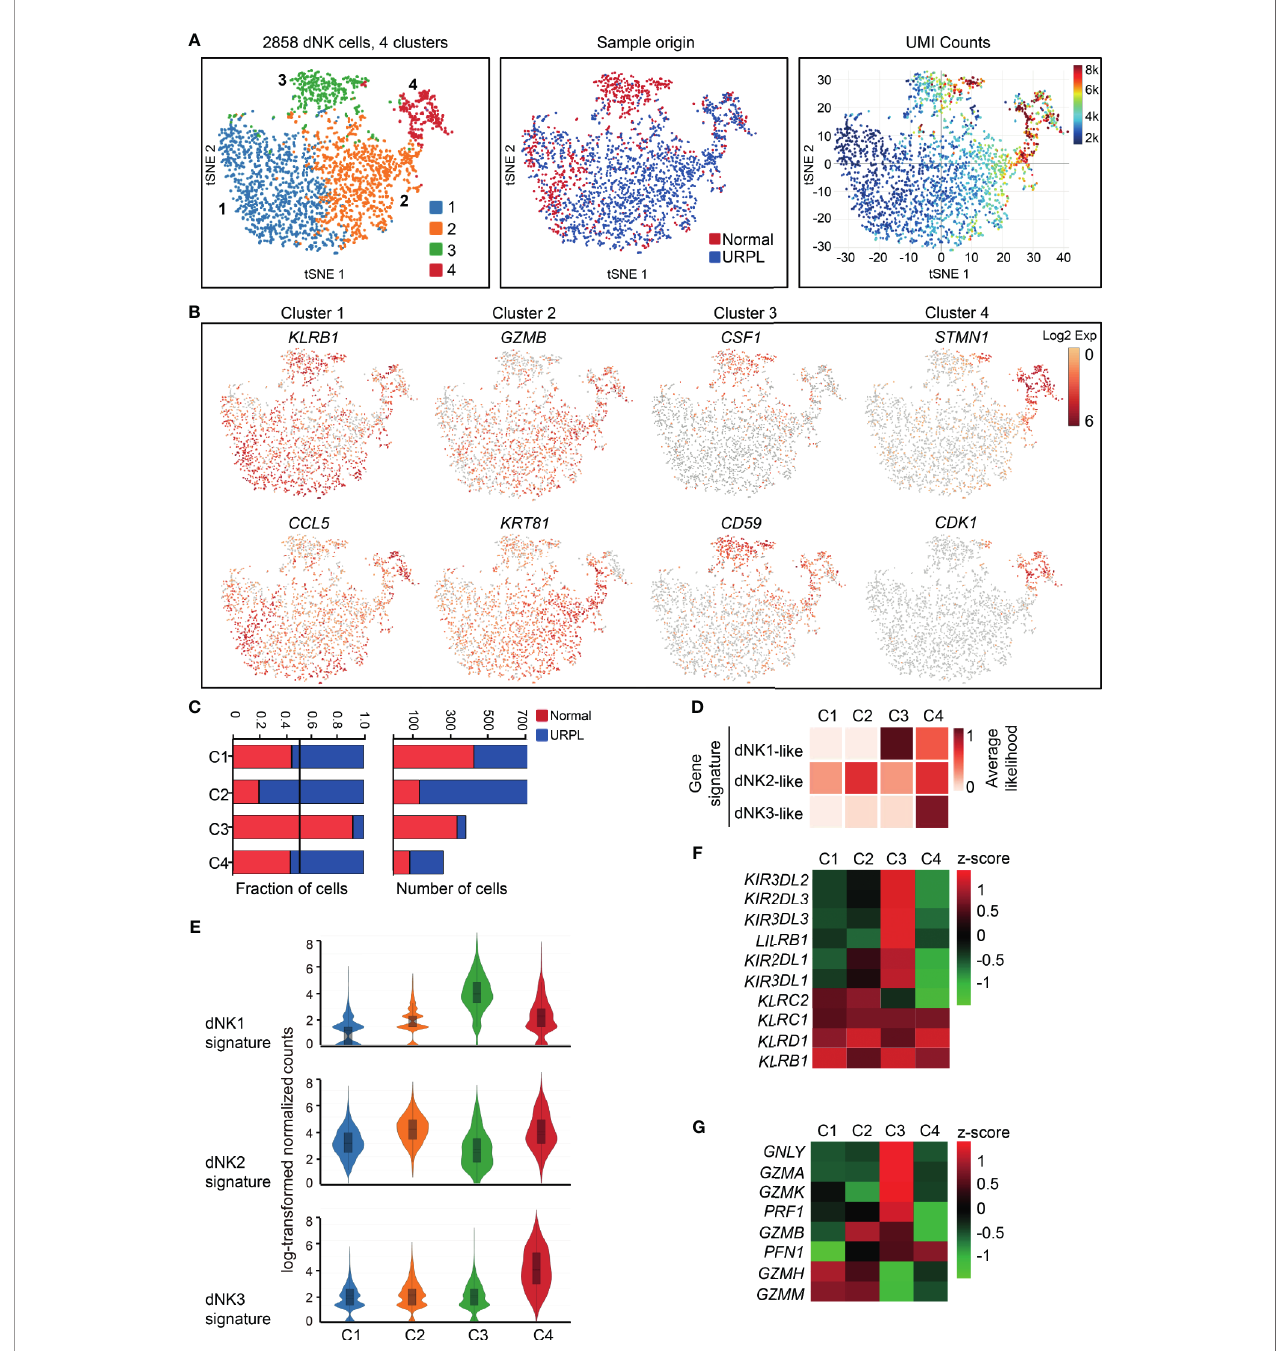
FIGURE 2 | Single-cell data revealed molecular details and subclusters of dNK cells. (A) tSNE of the dNK cells from Figure 1A (cluster 3,5,6), with each cell colorcoded for (left to right): the associated cell type, its sample type of origin (normal or URPL) and the number of transcripts (UMIs) detected in each cell (log scale as de fi ned in the inset). K, thousand. (B) Expression of marker genes for each subcluster above. (C) The fraction (left panel) and number (right panel) of cells originating from URPL and normal control samples for the 4 de fi ned subclusters. (D) Classi fi cation by dNK1, dNK2 and dNK3 gene signatures revealed the identity of the 4 subclusters above. (E) Violin plots showing the smoothened expression distribution of dNK1, dNK2 and dNK3 gene signatures in each dNK cell subclusters. (F) Heatmap of mean expression levels of KIR receptors within each subcluster. (G) Heatmap of mean expression levels of cytoplasmic granule proteins within each subcluster. Red and blue bar for normal (n=3) and URPL (n=3), respectively. Analysis of gene expression in scRNA-seq data was performed in R (version 3.5.2) using